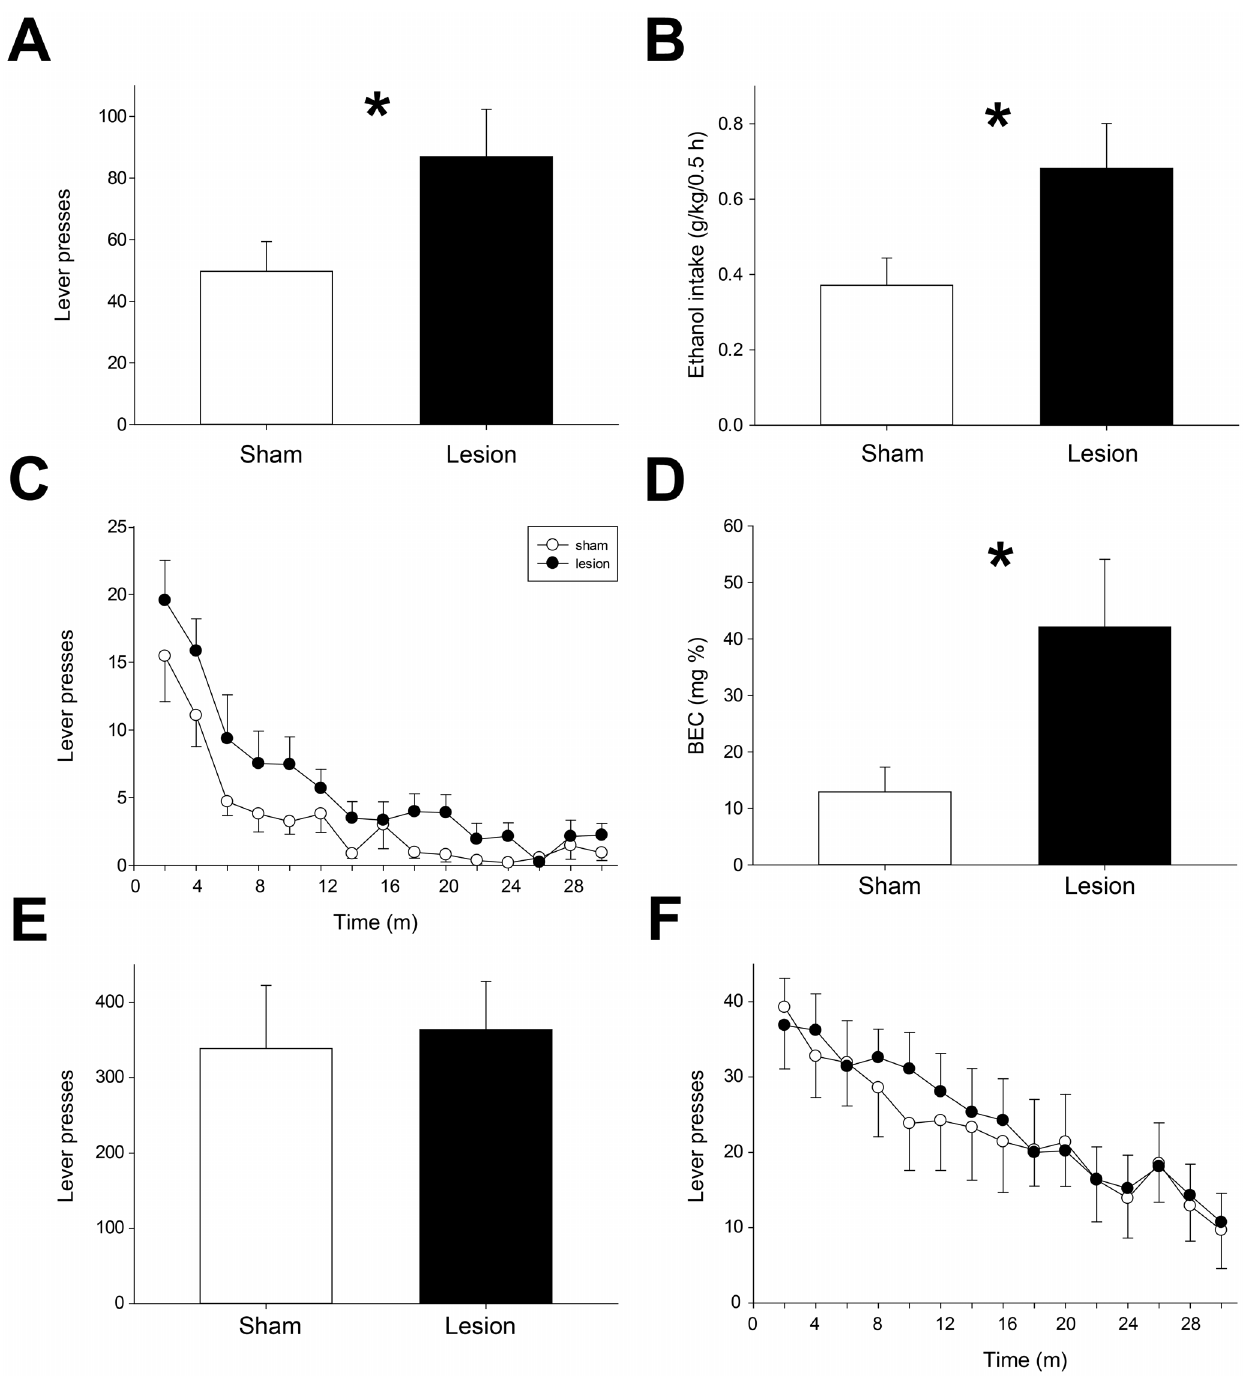
Figure 4. Operant self-administration of ethanol and sucrose . (A-B) Operant responding (A) for 20% ethanol was significantly higher in lesioned vs. sham rats, resulting in elevated levels of ethanol consumption (B). (C) Timing of lever pressing across 30 m self-administration sessions. Compared to sham animals, lesioned rats maintained elevated response rates for the duration of the session. (D) Operant self-administration resulted in significantly higher BECs in lesioned rats compared to sham rats. (E-F) Sham and lesioned rats showed similar levels of operant responding for 2% sucrose (E), and similar patterns of responding over the course of the 30 m session (F). doi:10.1371/journal.pone.0092701.g004 Similar to the results seen for reinstatement of ethanol seeking, administration resulted in a significant increase in operant yohimbine reinstated sucrose seeking in sham but not lesioned rats responding in the sham group relative to operant responding (Fig. 5D; significant interaction of lesion x drug, F(1, 13) = 6.5, p , after vehicle administration (19 6 4 vs. 5 6 2 lever presses after 0.05; also main effect of drug, F(1, 13) =6.4, p , 0.05). Yohimbine yohimbine and vehicle, respectively; p , 0.05, posthoc). A trend